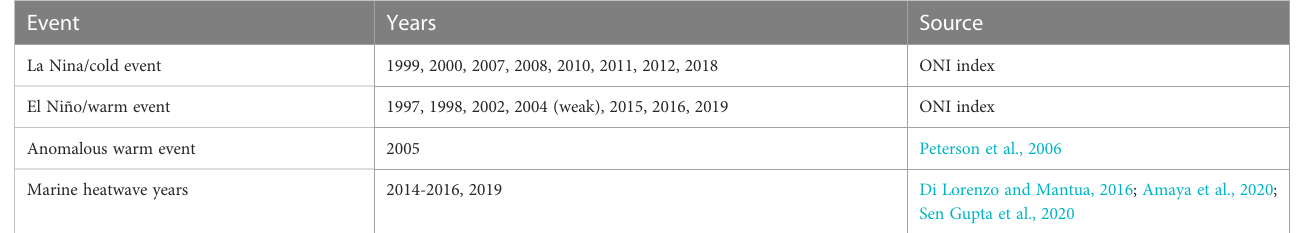
TABLE 2 Anomalous years in the northeast Paci fi c